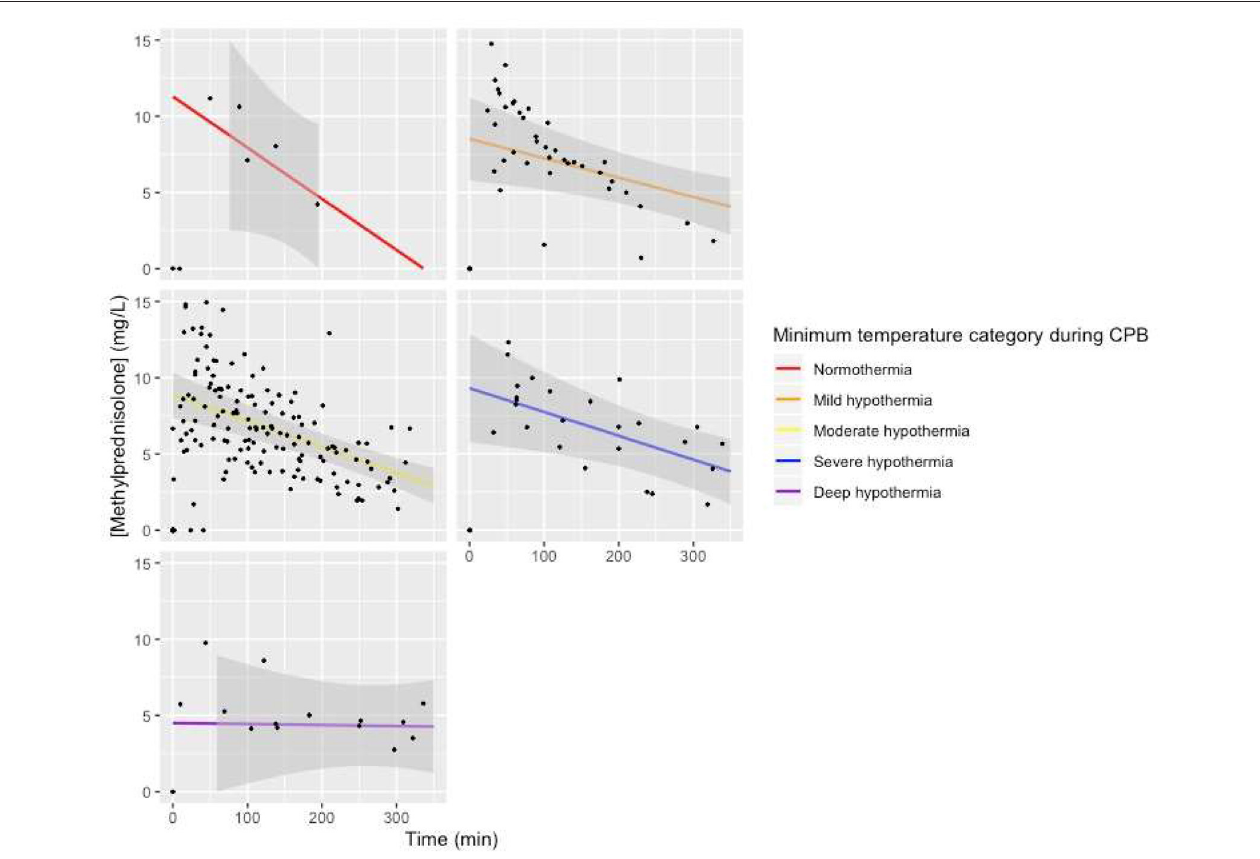
FIGURE 6 | Predicted MP concentration (mg/L) vs. time (min) for temperature categories based on the linear mixed-effects model. Gray ribbon: 95% confidence interval. T = 0: start of CPB.